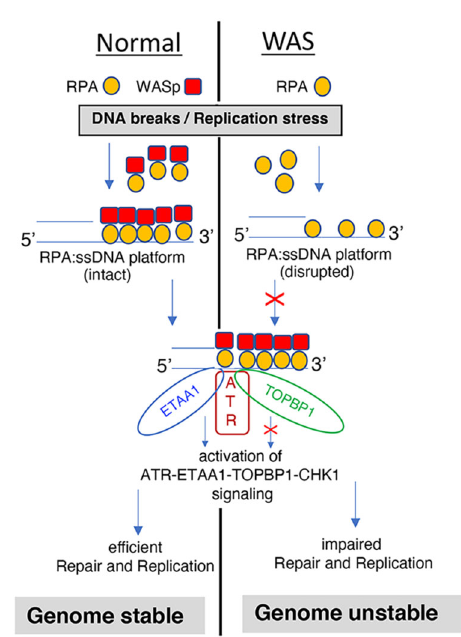
Fig. 7 Graphical abstract of WASp:RPA alliance in genome stability. Shown are the sequential steps in the HR pathway involved in DNA repair or replication reactions, and the effect of WASp de fi ciency on RPA-coupled mis-regulation of these critical steps/reactions, which ultimately lead to genome instability, spontaneously or